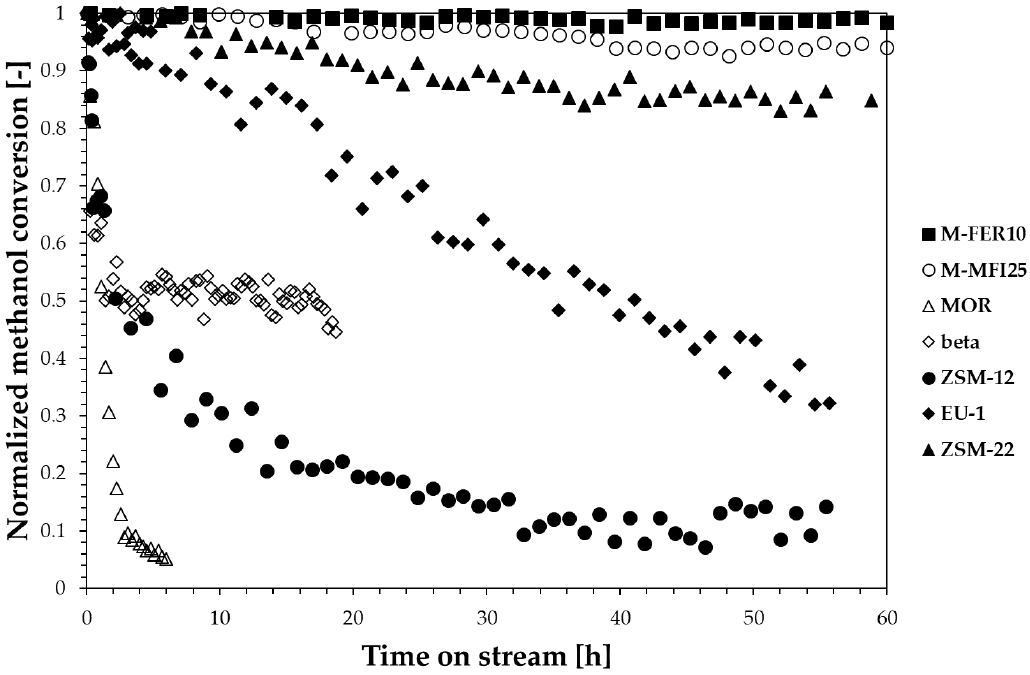
Figure 5. Normalised methanol conversion at 240 °C during time-on-stream tests.